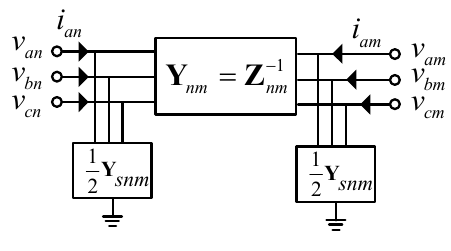
Figure 2. Three-phase line